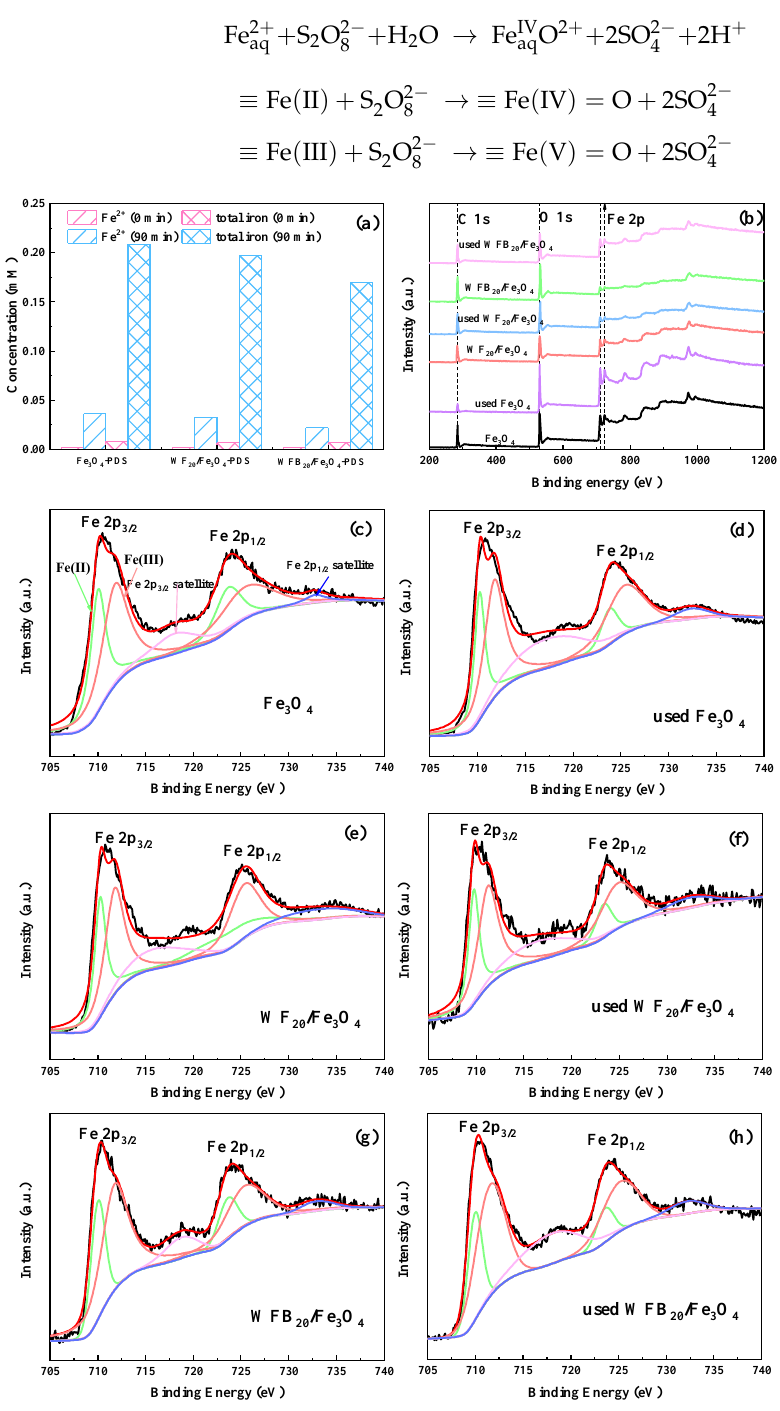
Figure 8. ( a ) Concentration of dissolved Fe 2+ and total irons in Fe 3 O 4 -PDS, WF 20 /Fe 3 O 4 -PDS, and WFB 20 /Fe 3 O 4 -PDS processes; the XPS of ( b ) full survey spectra and ( c – h ) the Fe 2p spectra of different catalysts (conditions: catalyst 1.0 g/L, [PDS] 0 = 5.0 mM, [BPA] 0 = 0.02 mM, pH 0 = 3.00 ± 0.1). To further study the catalytic mechanism of WFB in WFB 20 /Fe 3 O 4 , FT-IR spectra of fresh WFB and the used WFB were compared (Figure S6). After the catalytic reaction, the C=O groups (1736.27 cm −1 ) almost disappeared, indicating that the C=O groups on WFB were consumed during the catalytic reaction [65]. Thus, it was assumed that the C=O groups were mainly the functional groups contributing to the catalytic activity of WFB,